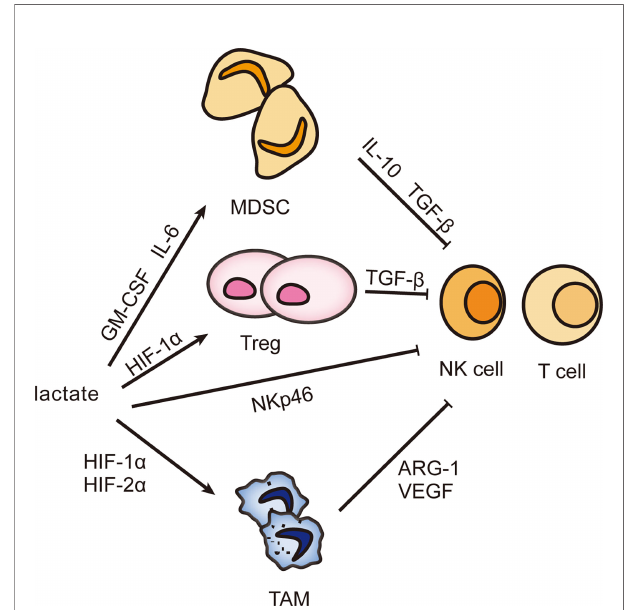
FIGURE 2 | Effect of lactate on in fi ltrating immune cells. The accumulation of lactate can induce the differentiation of MDSC, Treg, and TAM and stimulate their biological activities and then secrete immunosuppressive factors to inhibit the immune response of NK cells and T cells, helping tumor cells escape immune surveillance and gain unlimited growth potential.